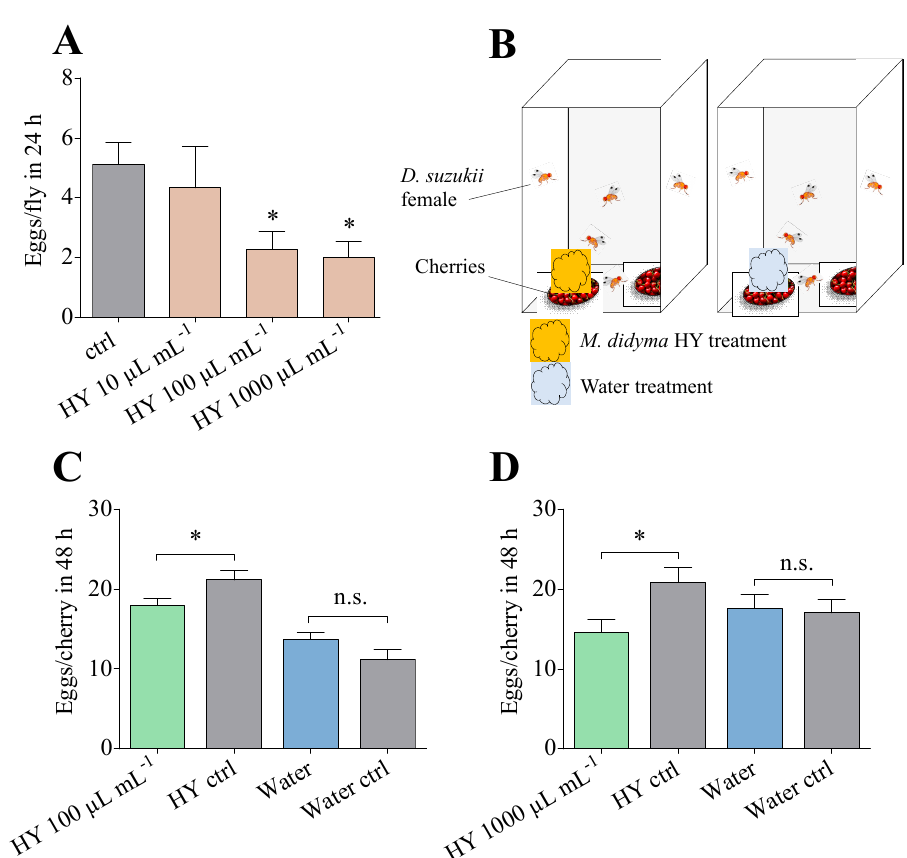
Figure 5. Effect of M. didyma HY on D. suzukii egg-laying. ( A ) The eggs (mean ± SEM) laid in 48 h by a single D. suzukii female with or without different amounts of M. didyma HY in the diet. * p < 0.05 according to one-way ANOVA followed by Dunnett’s test for multiple comparisons. ( B ) The schematic representation of the cherry oviposition assay performed with D. suzukii female adults. ( C , D ) The eggs (mean ± SEM) laid on one cherry with or without 100 µL mL − 1 ( C ) and 1000 µL mL − 1 ( D ) M. didyma HY. n.s. not significant; * p < 0.05 according to Student’s t -test.